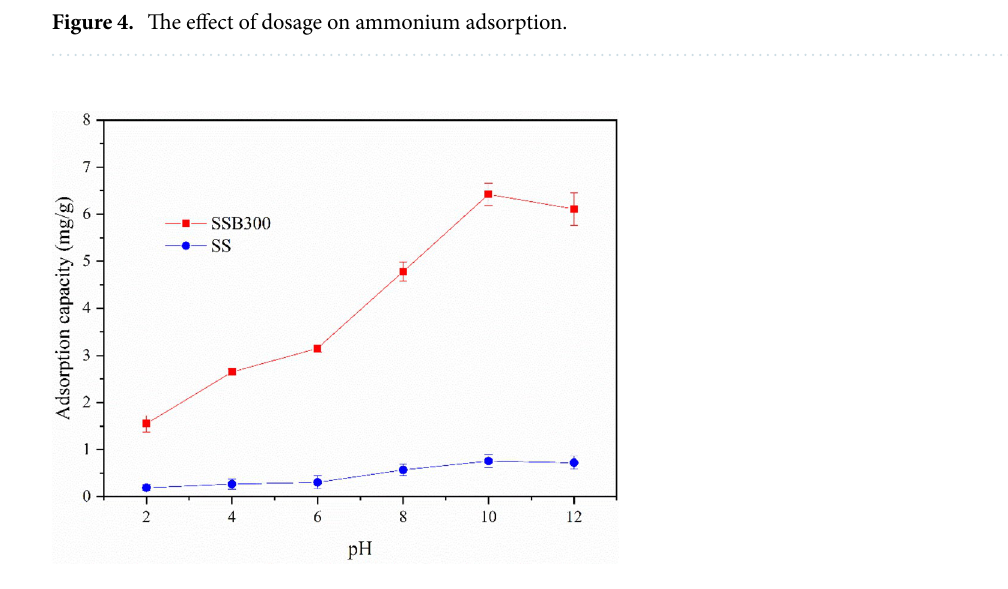
Figure 5. The effect of pH on ammonium